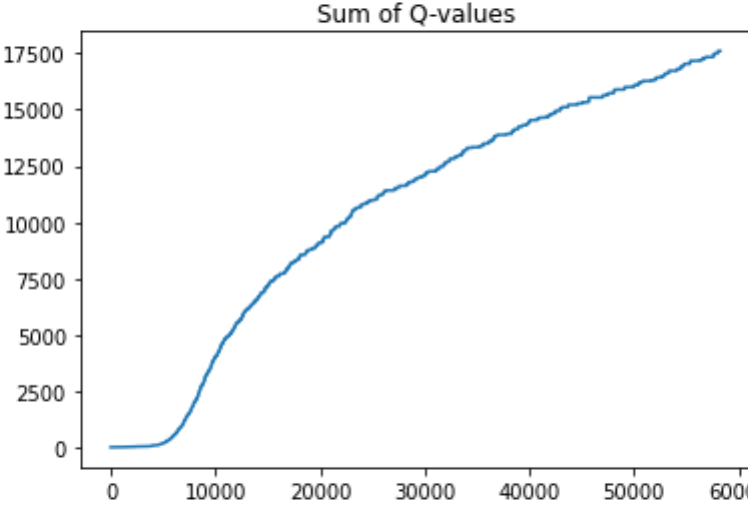
Figure 17. Sum of Q values.